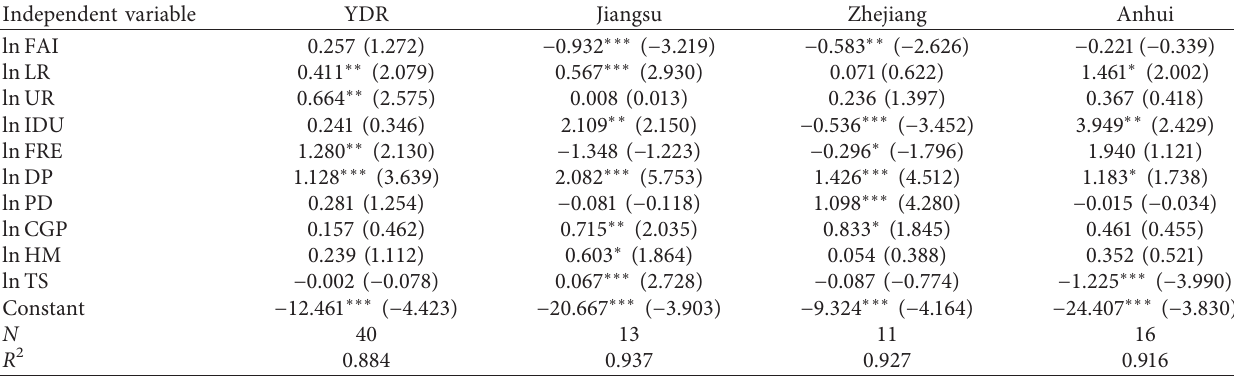
Table 9: Regression results of enterprise